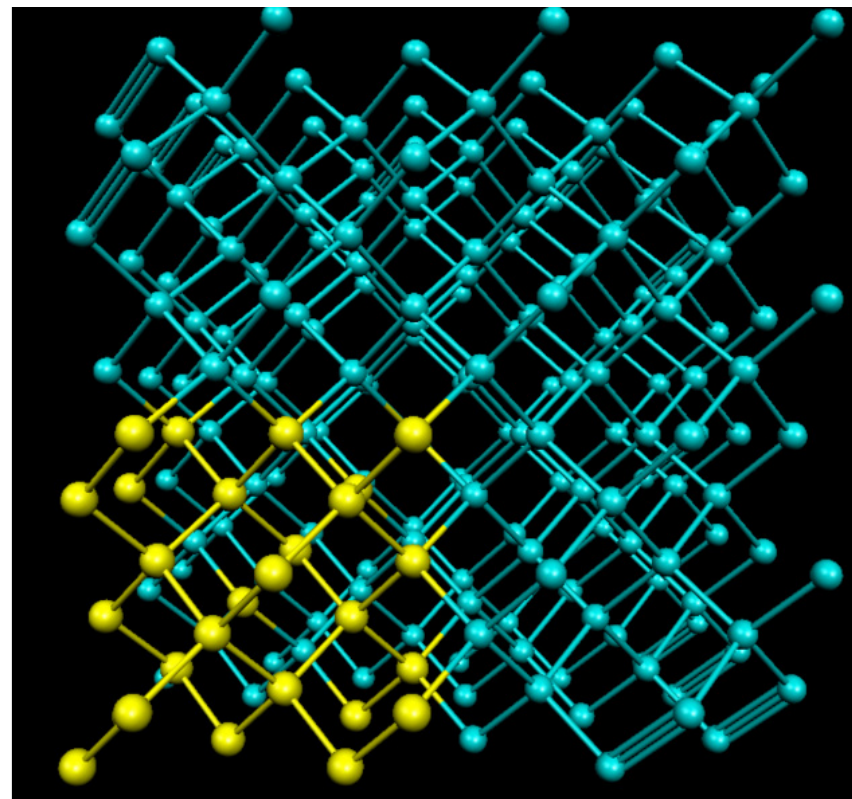
Figure 1. Shown above is an example of one of the supercells used in our calculations. The blue and yellow atoms are both Ge, where the yellow atoms denote the hot block atoms. yellow atoms are both Ge, where the yellow atoms denote the hot block